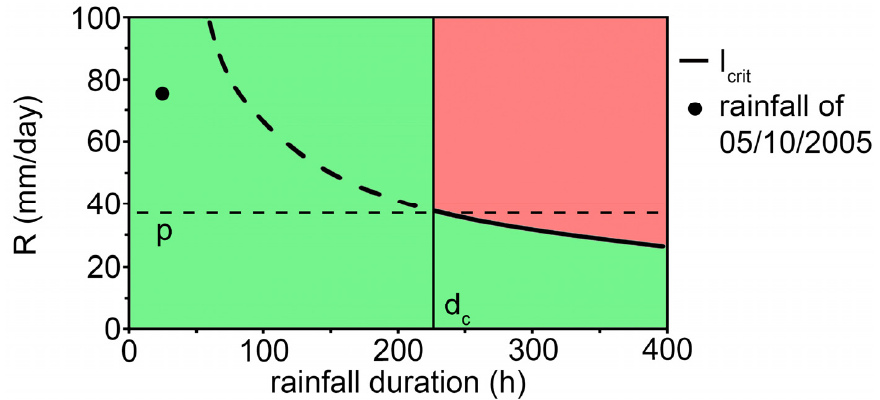
Figure 11. Comparison between the rainfall event recorded on 10 April 2005 and the critical curve calculated at the depth of 1.40 m.